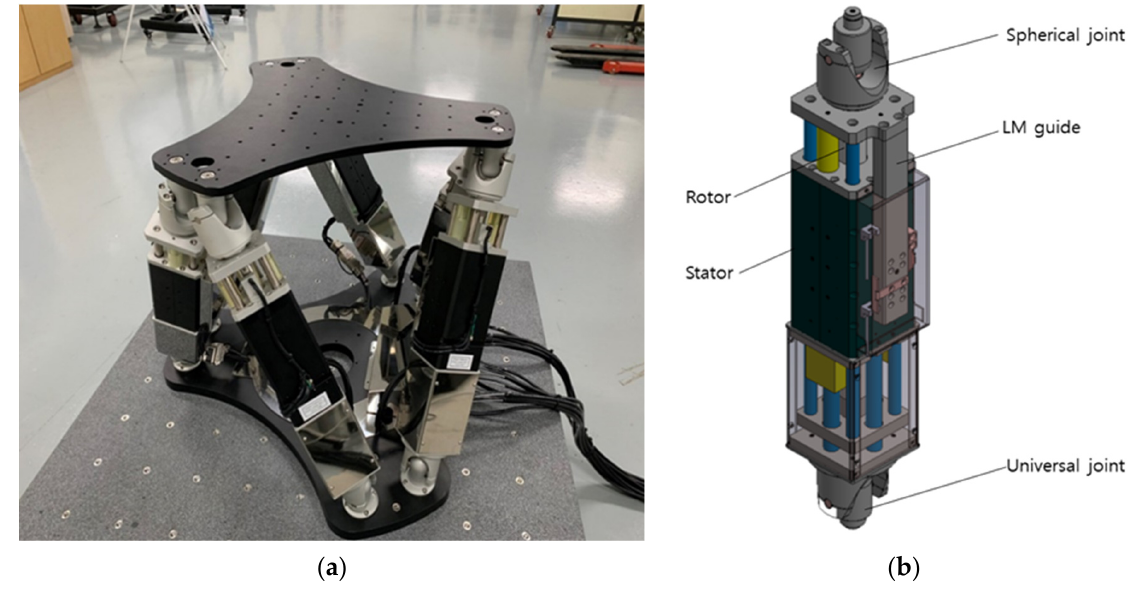
Figure 4. Stewart platform: ( a ) configurations, ( b ) linear electromagnetic actuator.